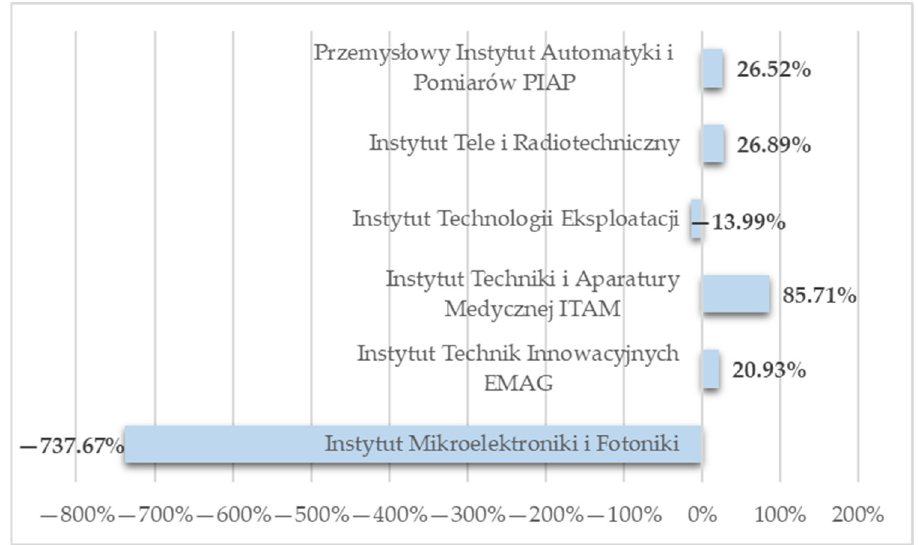
Figure 5. Change in net profit at researched institutes over the period 2019–2020 [in %]. Source: [97].